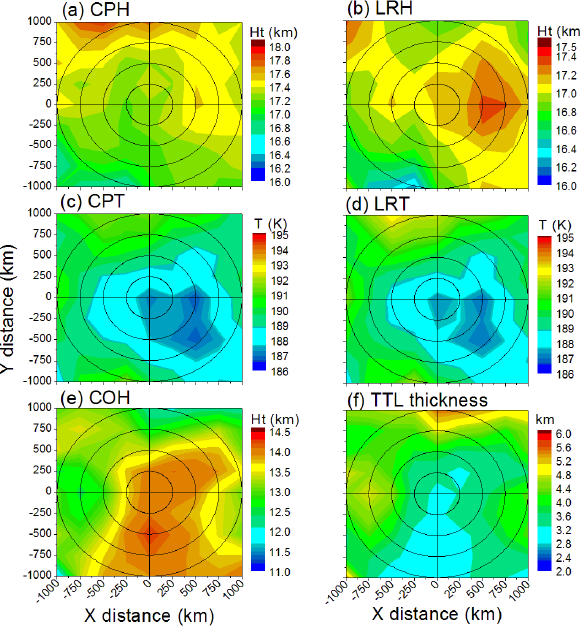
Figure 4. Cyclone-centred composite of (a) CPH, (b) LRH, (c) CPT, (d) LRT, (e) COH, and (f) TTL thickness observed dur- ing the CS and